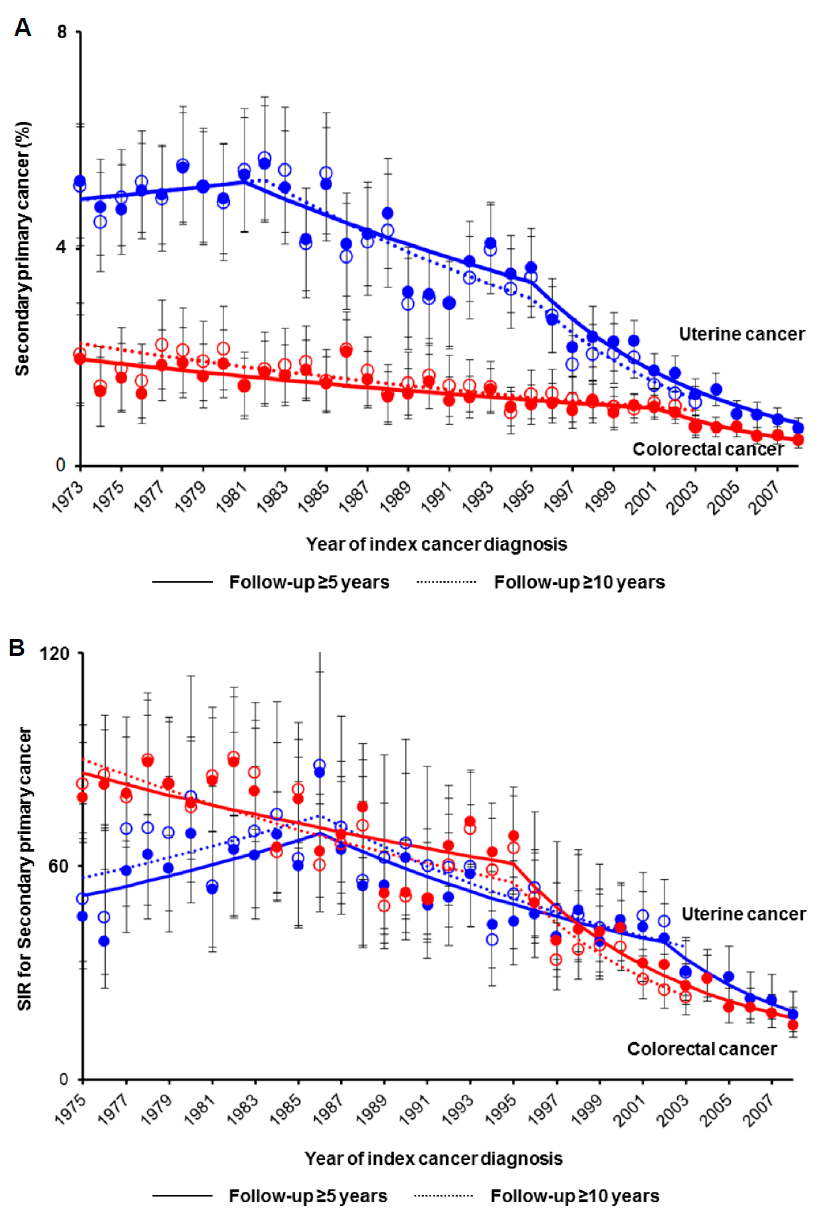
Figure 3. Trends of postcedent secondary primary cancer among cancer survivors per year. Among women who were alive at a follow-up ≥ 5 years (solid lines) or ≥ 10 years (dashed lines), ( A ) temporal trends of the incidence of postcedent secondary cancer and ( B ) standardized incidence ratio were examined. Dots represent actual observed values. Bars represent standard confidence intervals. Colored lines represent modeled lines. Blue lines represent the uterine cancer cohort, and red lines represent the colorectal cancer cohort, respectively. Raw results of temporal trends are shown in Supplemental Tables S5 and S6. Median follow-up times across the study period are shown in Supplemental Figure S2. Abbreviation: SPC, secondary primary cancer; and SIR, standardized incidence ratio.